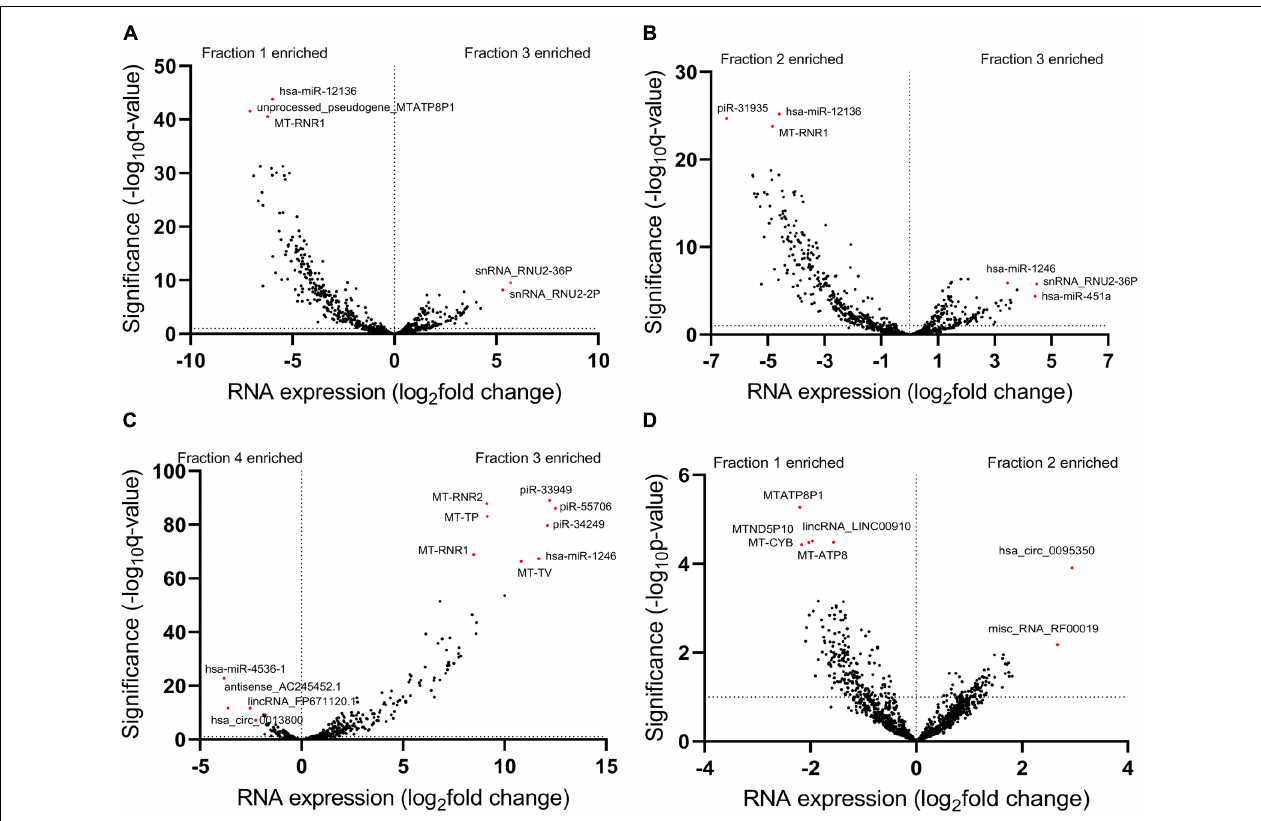
FIGURE 5 | Differentially enriched transcripts between different fractions. (A–C) Volcano plots show differentially enriched transcripts of the EV Precipitate versus the other three fractions. (D) Volcano plot shows differentially enriched transcripts between Precipitate 1 and Precipitate 2. Horizontal dashed line represents